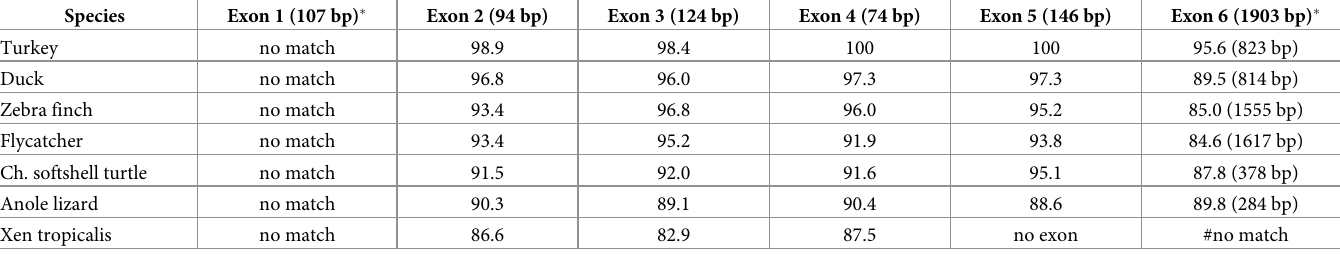
Mapping the 3’ end of exon 6 with the same RNA-sequencing libraries led to identification of a 3’ UTR of 499 base pairs, and a total exon length of 643 base pairs, which included near its 3’ end a ‘ ATTAAA ’ presumptive poly A recognition sequence and 12 base pairs further 3’, a Table 3. Nucleotide identity with chicken Zmat2